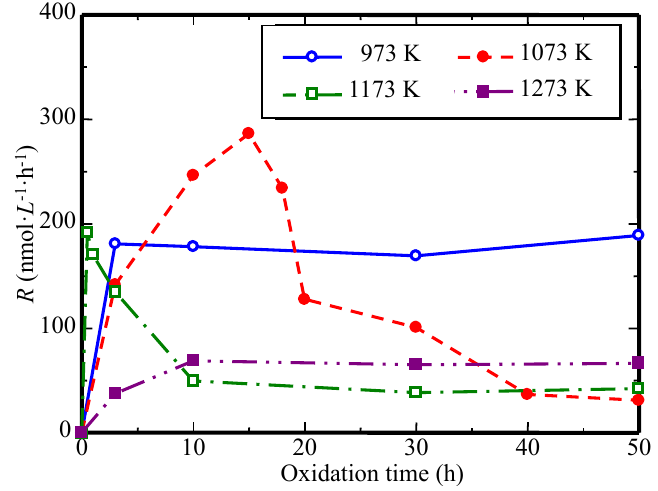
Figure 40. Relationship between dependence of degradation rate constants and the oxidation